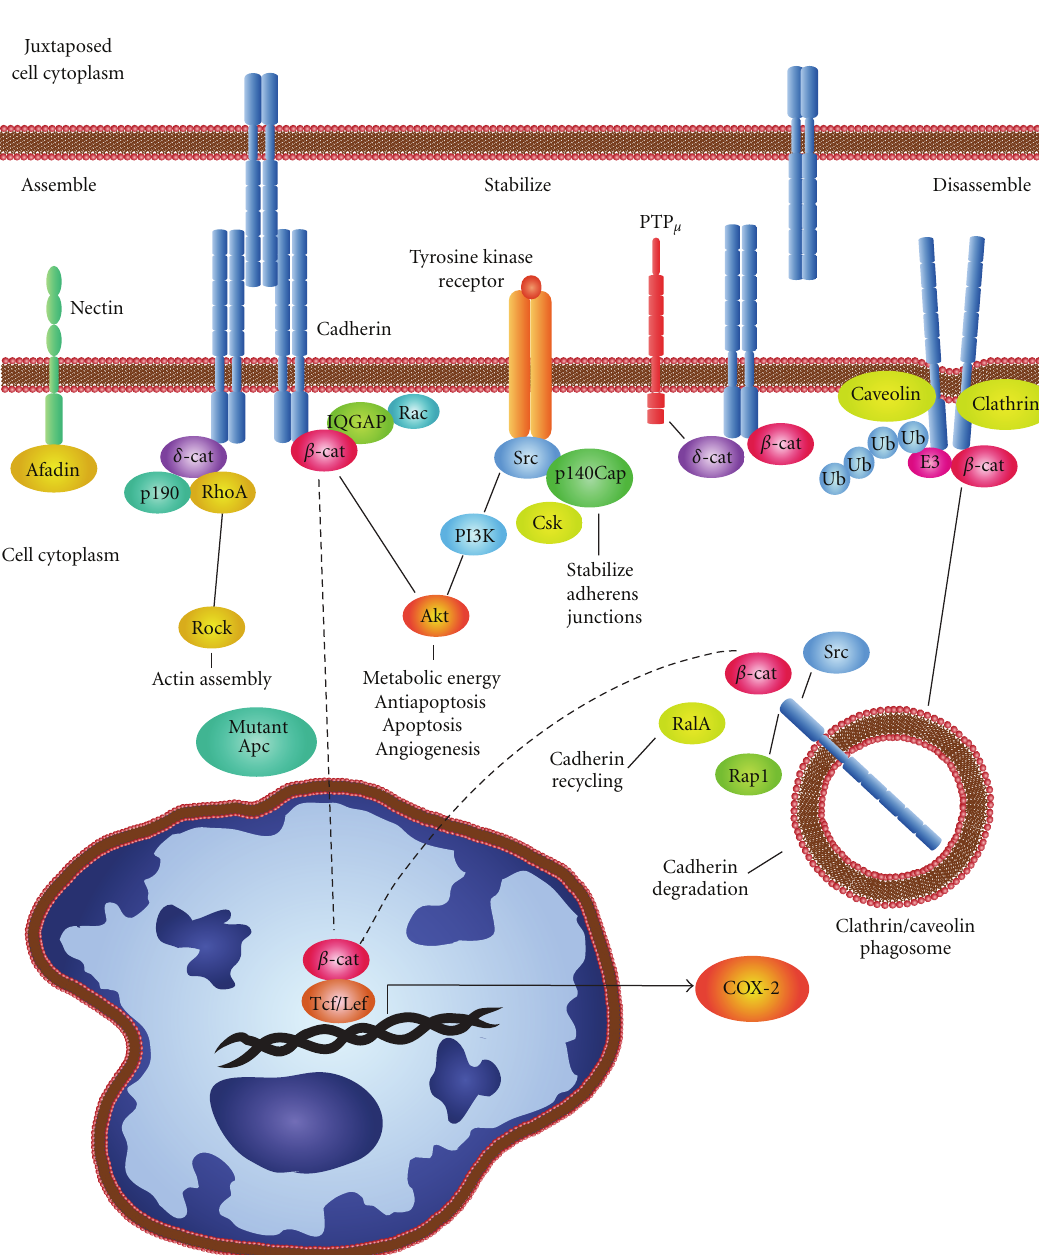
Figure 2: Dynamic adherens junctions. Prostaglandins influence the assembly, stabilization, and disassembly of cell-cell junctions. E- cadherins form Ca 2+ -dependent transmembrane adhesion complexes between adjacent cells (Figure 2). Cytoplasmic regulatory proteins include α -catenin, β -catenin, IQGAPs sca ff old proteins that interact with Rho GTPases to alter morphology and migration. Alternate interactions involve δ -catenin, p190, and RhoA influencing actin assembly. Together, Src and p140Cap influence C-terminal Src kinase (Csk) activity stabilizing cell-cell interactions as well as similar activity by receptor protein tyrosine phosphatase mu (PTP μ ). Nectins- afadin complexes also cooperate with cadherins and integrins to regulate cell-cell adhesion. Disassembly of cadherin complexes involves either caveolin- or clathrin-mediated endocytosis and phagosome formation. Inside-out vesicles contain cadherin on the inside and β - catenin and Src exposed to the cytoplasm. When these vesicles interact with Ras-related protein A (RalA), cadherins are recycled. Whereas, interactions with Ras-proximate-1/Ras-related protein-1-(Rap1-)GTPase and E3 ubiquitin ligase followed by ubiquitinization result in proteosomal degradation that prepares cells for migration. The loss of E-cadherin in conjunction with elevations in COX-2 occurs during the transformation and adenoma formation in the presence of Apc mutations causing aberrant β -catenin signaling. Subsequent interactions with T-cell factor/lymphoid-enhancer-factor-(TCF/LEF-) can cause increases in COX-2